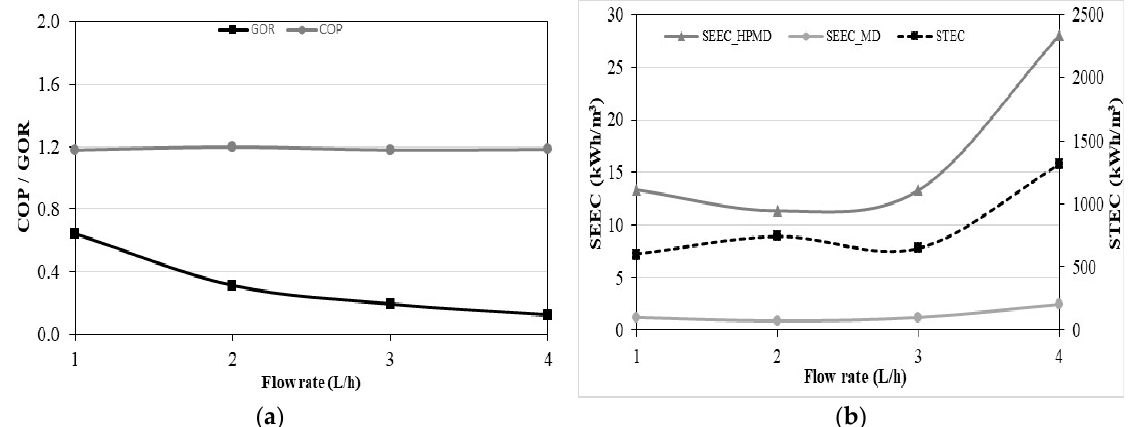
Figure 17. Effect of flow rate, on ( a ) COP and GOR, ( b ) STEC and SEEC in food storage mode.